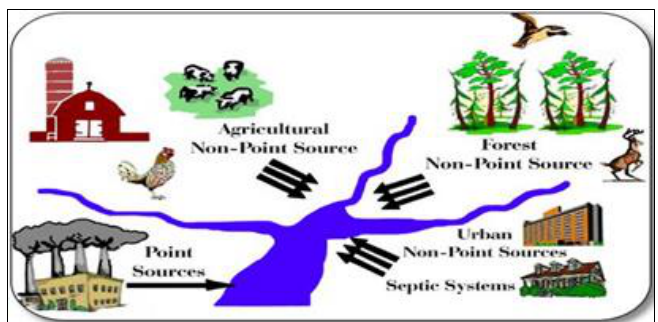
Figure 1: Schematic diagram of Non-point pollution sources in a typical